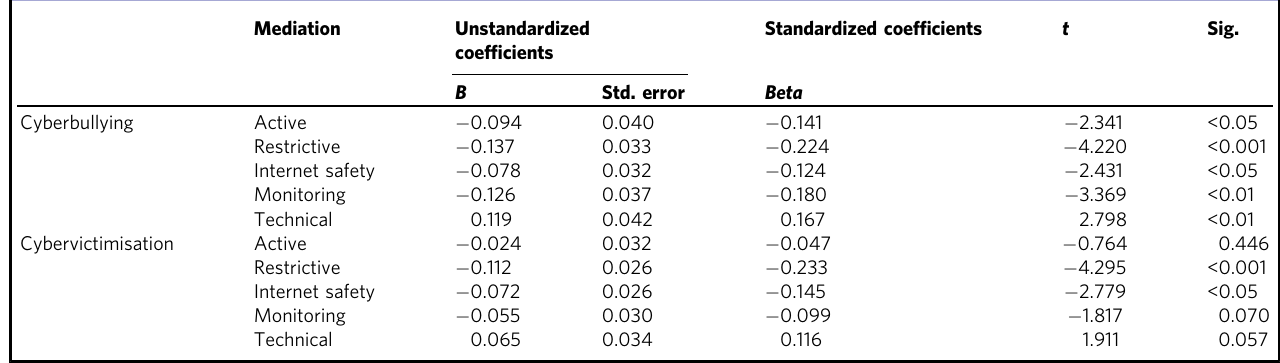
Table 5 Coef fi cients for the two analyses of the relationship between internet mediation strategies and adolescent internet bullying and victimization.